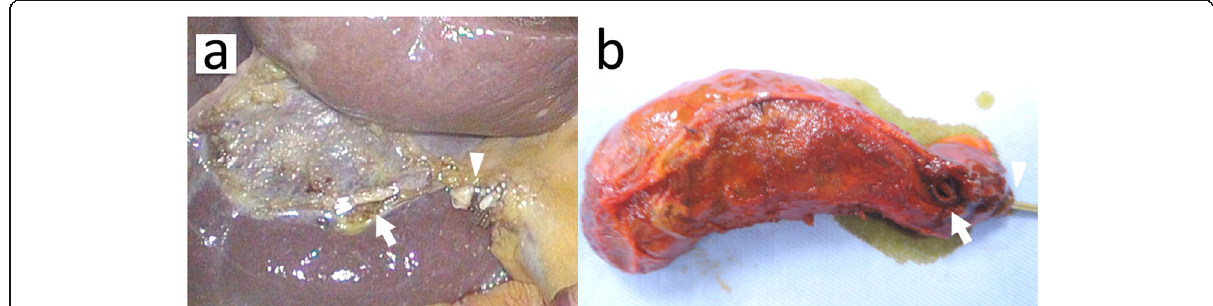
Fig. 2 a Intraoperative photographs revealing the cholecystohepatic duct stump in the gallbladder bed (arrow) and the stump of the cystic duct (arrowhead). b The cholecystohepatic duct orifice was confirmed in the resected gallbladder neck (arrow). An arrowhead shows the cystic duct stump